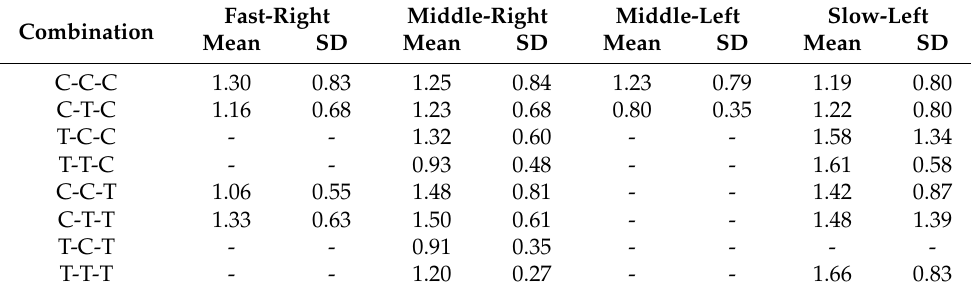
Table 2. The mean and standard deviation of T b of n3.